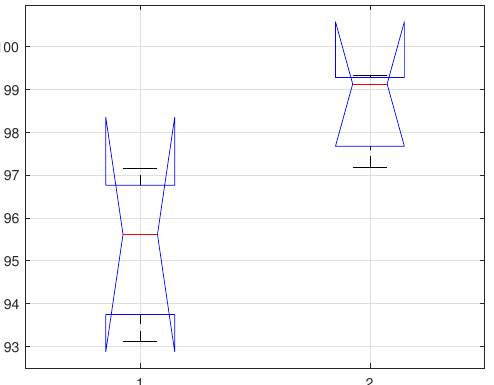
Figure 9. Confidence Interval of selected classifiers using statistical features of PSD